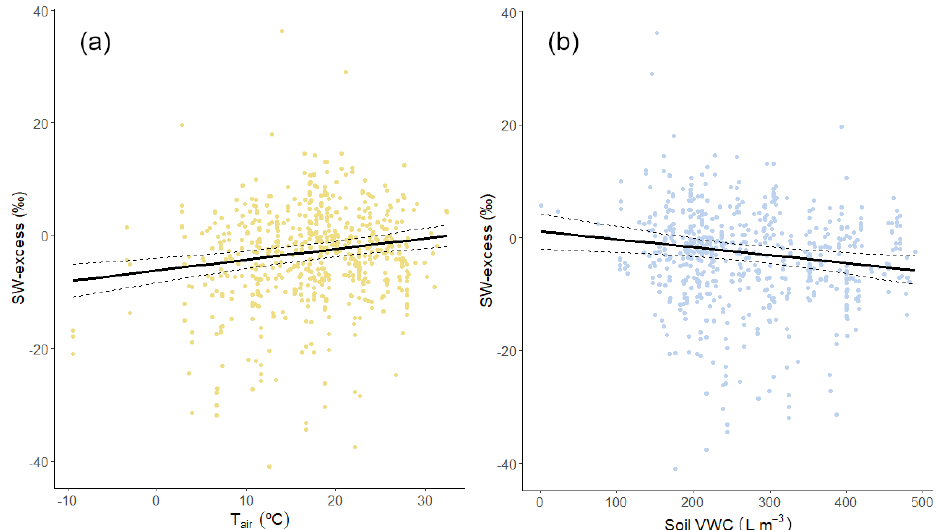
Figure 4. Soil water excess (SW-excess) plotted against (a) mean monthly air temperature ( T air ) and (b) monthly soil volumetric water content (VWC) of the upper 100cm. Each point is the mean SW-excess per species and campaign (observations from a given sampling event and plot/site within a study). The solid and dashed lines are the prediction and standard error of the corresponding linear mixed model, with a single predictor